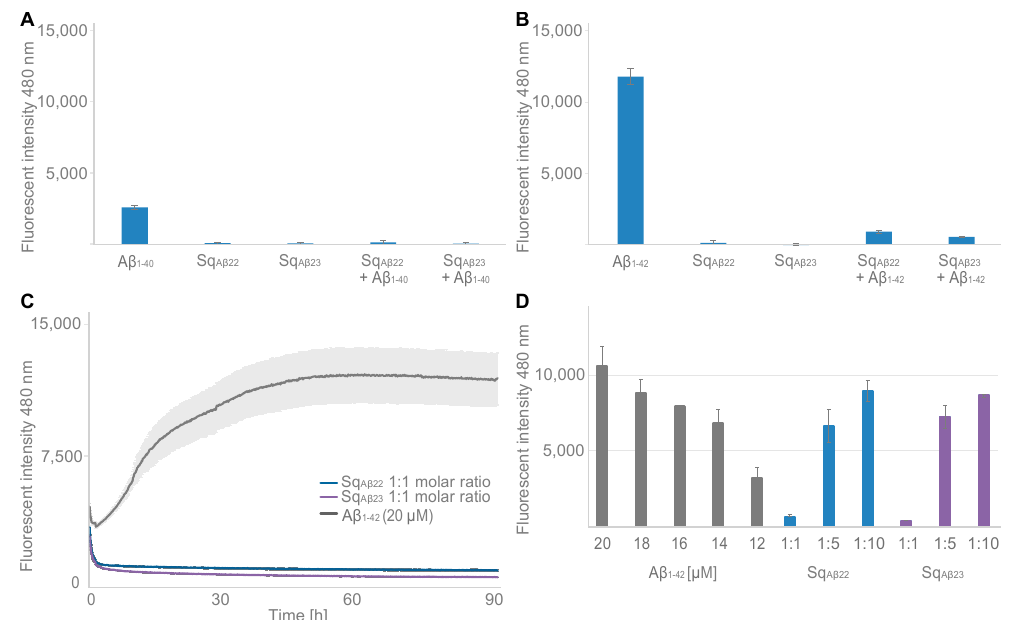
Figure 6. Aggregation assay measuring thioflavin T (ThT) fluorescence at 480 nm. ( A ) Histogram showing endpoint ThT fluorescence at 92 h for 20 μ M A β 1–40 , 20 μ M Sq A β 22 , 20 μ M Sq A β 23 , 1:1 molar ratio of 20 μ M A β 1–40 + 20 μ M Sq A β 22 and 1:1 molar ratio of 20 μ M A β 1–40 + 20 μ M Sq A β 23 . ( B ) Histogram showing endpoint ThT fluorescence at 92 h for 20 μ M A β 1–42 , 20 μ M Sq A β 22 , 20 μ M Sq A β 23 , 1:1 20 μ M A β 1–42 + 20 μ M Sq A β 22 and 1:1 20 μ M A β 1–42 + 20 μ M Sq A β 23 . ( C ) ThT fluorescence monitored for 92 h for 20 μ M A β 1–42 (grey), 1:1 molar ratio of 20 μ M A β 1–40 + 20 μ M Sq A β 22 (blue) and 1:1 molar ratio of 20 μ M A β 1–40 + 20 μ M Sq A β 23 (purple). ( D ) Histogram showing endpoint ThT fluorescence at 92 h for 12–20 μ M A β 1–40 (in grey), and sequestrins Sq A β 22 (blue) and Sq A β 23 (purple) at different molar ratios of 1:1, 1:5 and 1:10 in 20 μ M A β 1–42. Standard deviation of the replicates is shown in the graph.